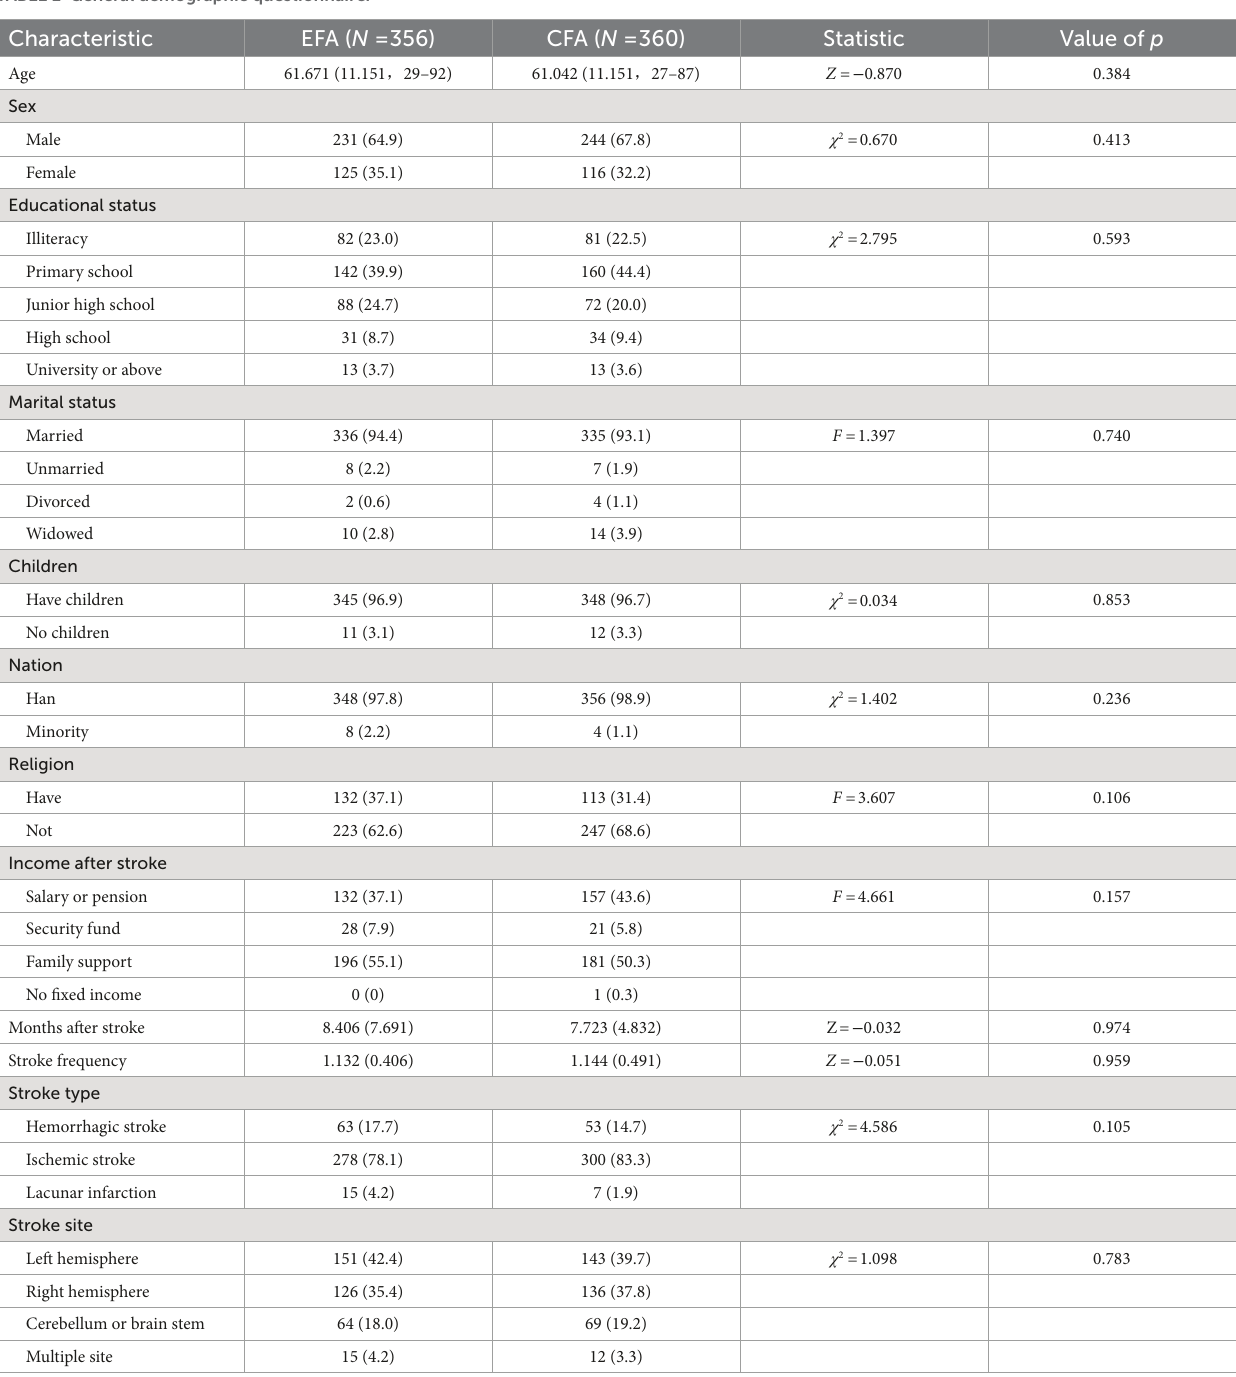
TABLE 1 General demographic